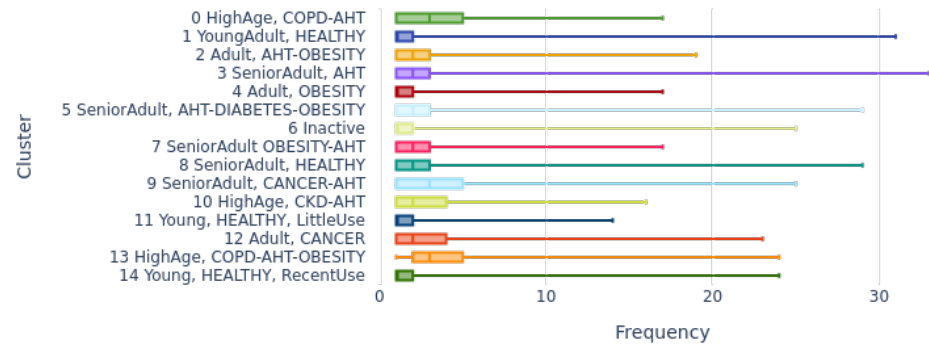
Figure 8. Distribution by frequency of use cluster.